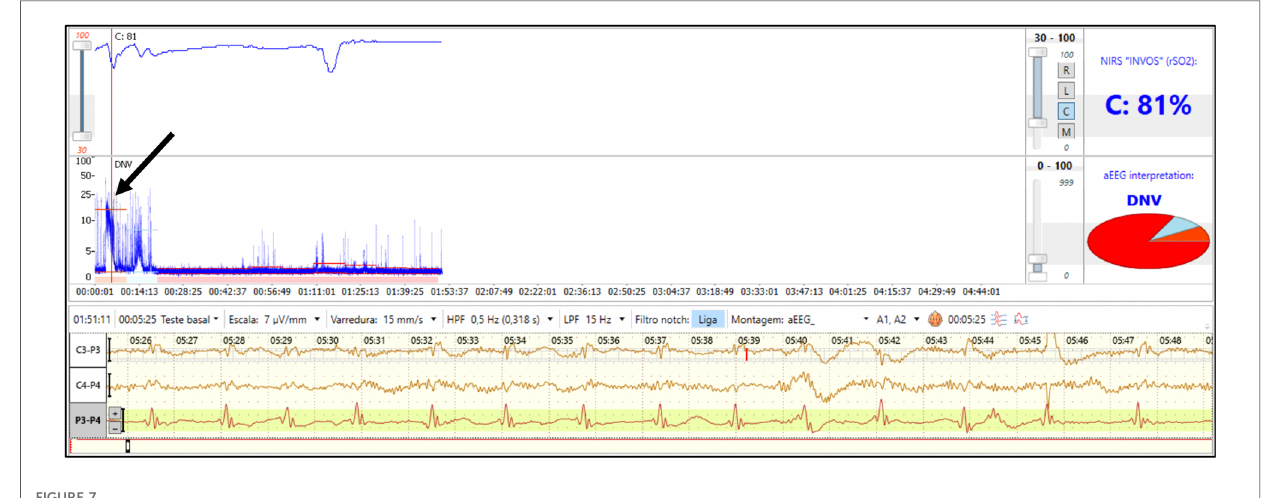
FIGURE 7 Combined neuromonitoring with aEEG and NIRS in a preterm infant with clinical seizures on the fi rst day of life after severe anemia. The aEEG shows a fl at tracing with seizure activity (arrow). Simultaneous NIRS tracing shows supranormal rScO2 Which transiently decreases during seizure activity (reproduced with permission from Variane GFT, Chock VY, Netto A, Pietrobom RFR, Van Meurs KP. Simultaneous Near-Infrared Spectroscopy (NIRS) and Amplitude- Integrated Electroencephalography (aEEG): Dual Use of Brain Monitoring Techniques Improves Our Understanding of Physiology. Front Pediatr. 2019;7:560).